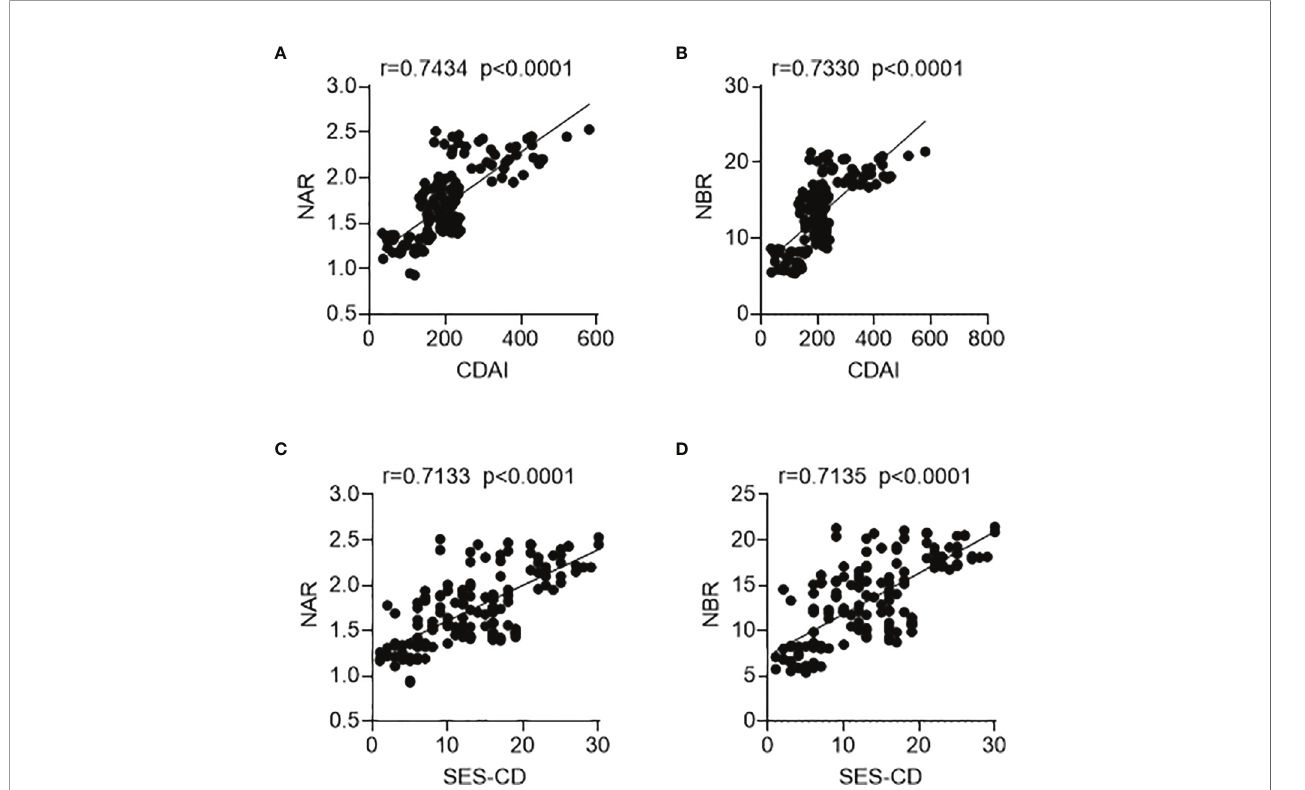
FIGURE 2 | Associations of NAR and NBR with disease activity. A total of 144 patients with CD were enrolled. For clinical activity analysis, (A) NAR and (B) NBR were positively correlated with CDAI. For mucosal disease activity analysis, (C) NAR and (D) NBR were also positively associated with SES-CD. The correlation analysis was performed using Pearson ’ s correlation. p < 0.05 was considered signi fi